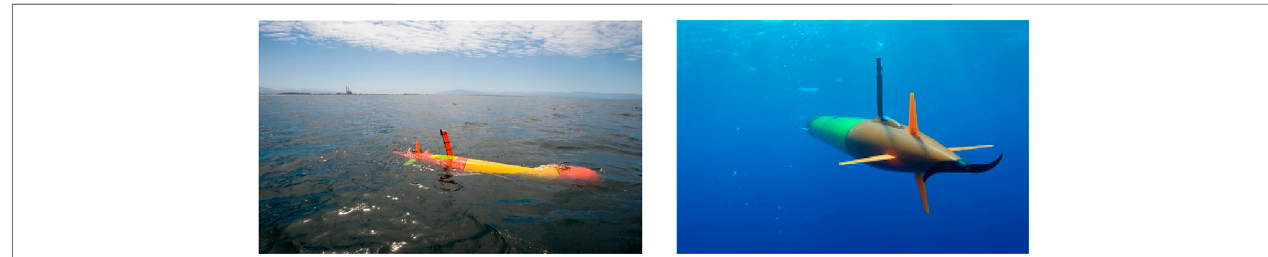
FIGURE 1 | Two instances of a Tethys-class vehicle deployed in the ocean (MBARI, 2009).